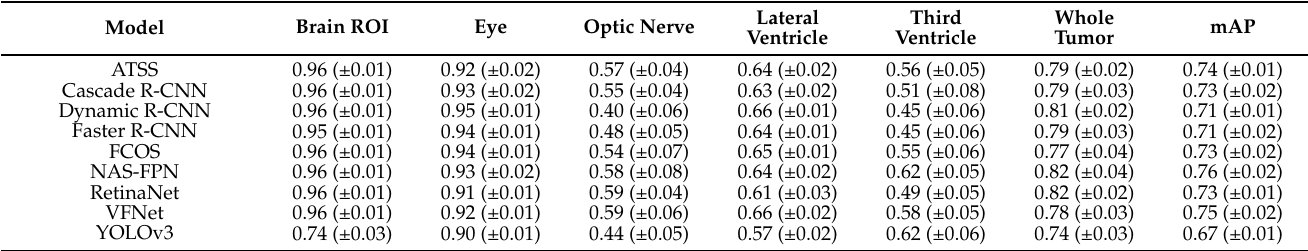
Table 4. Class-based average precision results with tenfold cross-validation on the test set. Model Brain ROI Eye Optic Nerve Lateral Ventricle Third Ventricle Whole